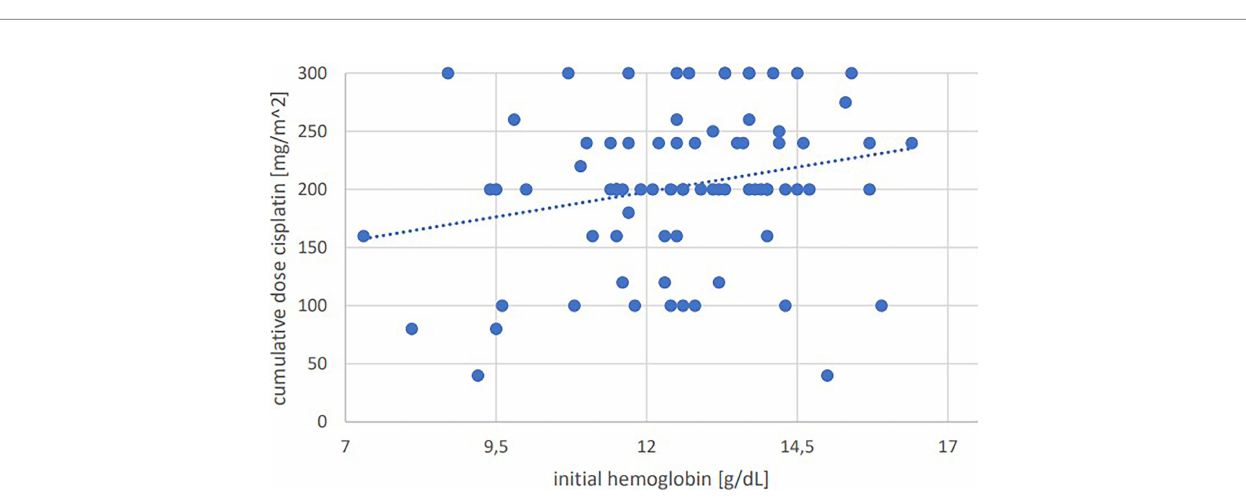
FIGURE 2 | Bivariate correlation analysis of initial hemoglobin values [g/dL] with fi nal cumulative total dose of cisplatin achieved [mg/m^2]: p=0.035, Pearson ’ s r=0.237; individual values as points, dashed linear trend